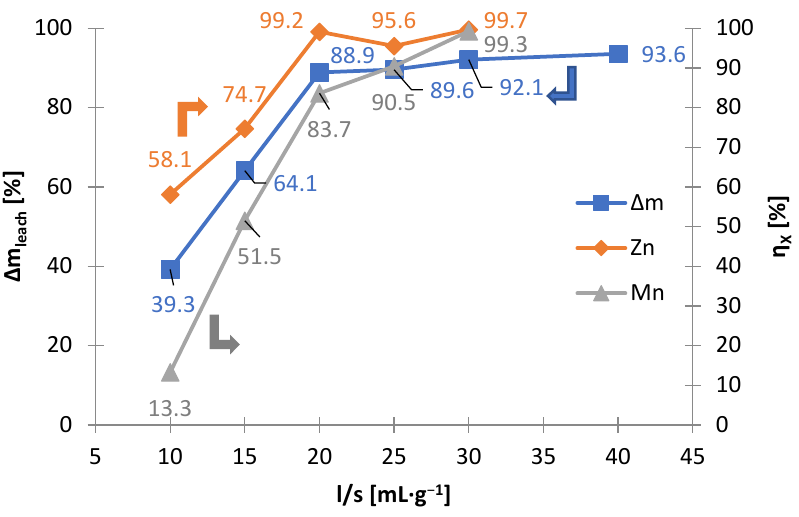
Figure 8. Effects of liquid-to-solid ratio (l/s) on mass loss of solid phase ( ∆ m leach ) and leaching yields ( η X ) of zinc and manganese as a result of non-selective leaching of black mass.